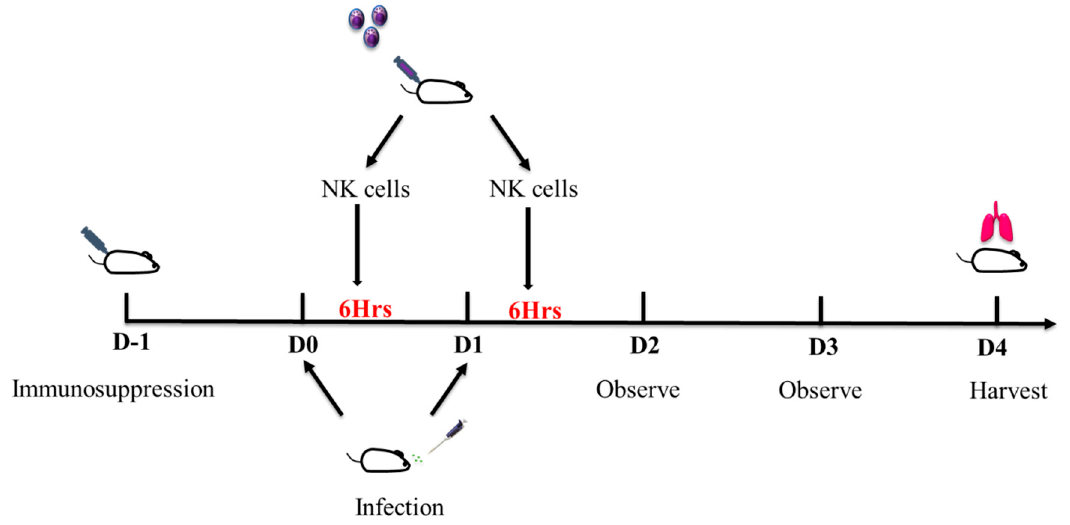
Figure 1. Pulmonary Aspergillosis mice model. Schematic diagram of administration of expanded natural killer cells and A. fumigatus natural killer cells and A. fumigatus .